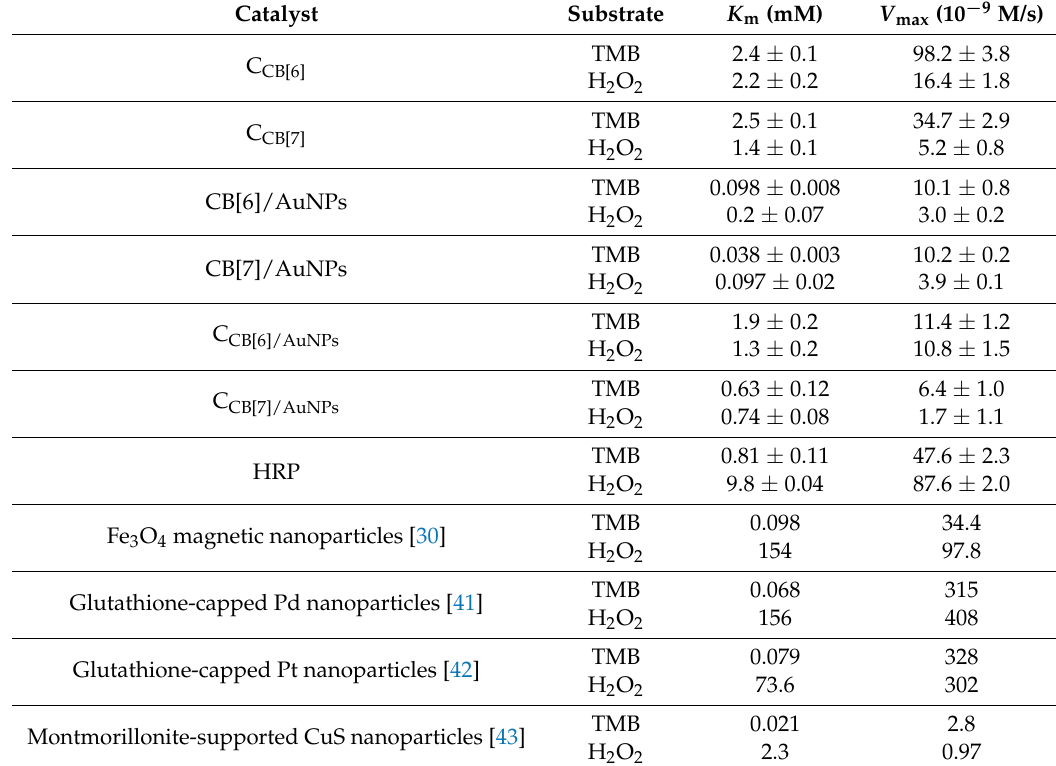
Table 1. Michaelis-Menten constant ( K m ) and maximum reaction rate ( V max ) of different nanomaterials in this work and